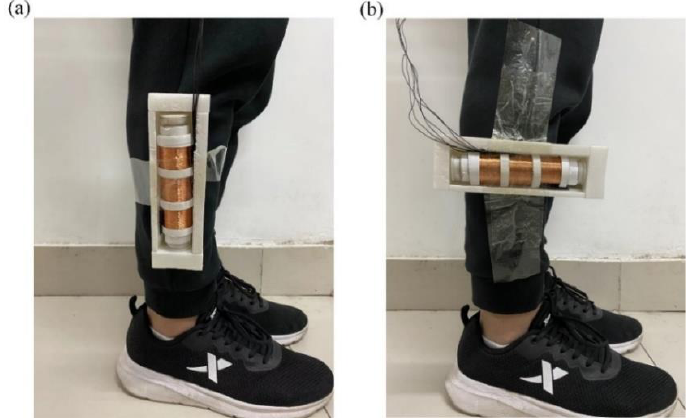
Figure 13. Picture of the human motion excitation test: ( a ) parallel to the leg ; ( b ) vertical to the leg.